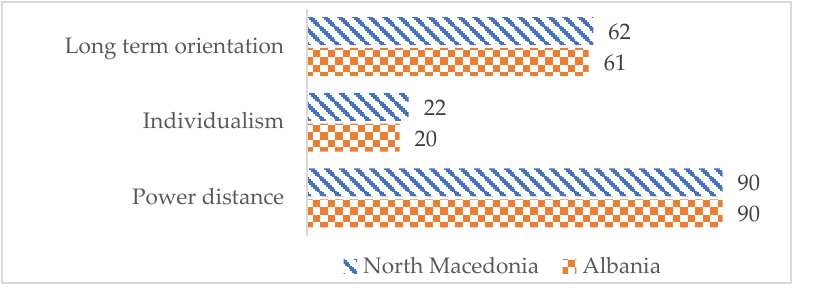
Figure 2. Hofstede ’ s cultural dimensions for Albania and North Macedonia. Source : Hofstede In- Figure 2. Hofstede’s cultural dimensions for Albania and North Macedonia. Source : Hofstede sights: https://www.hofstede-insights.com/ (accessed on 22 October 2022). Insights: https://www.hofstede-insights.com/ (accessed on 22 October 2022).